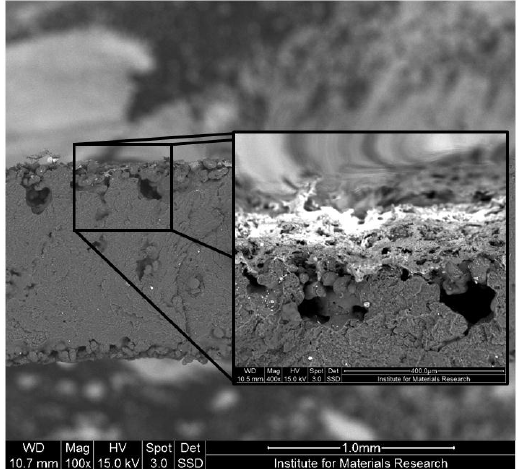
Figure 6. Scanning electron microscope cross-sectional image of a PVDF-coated SLS substrate by pneumatic spray coating.